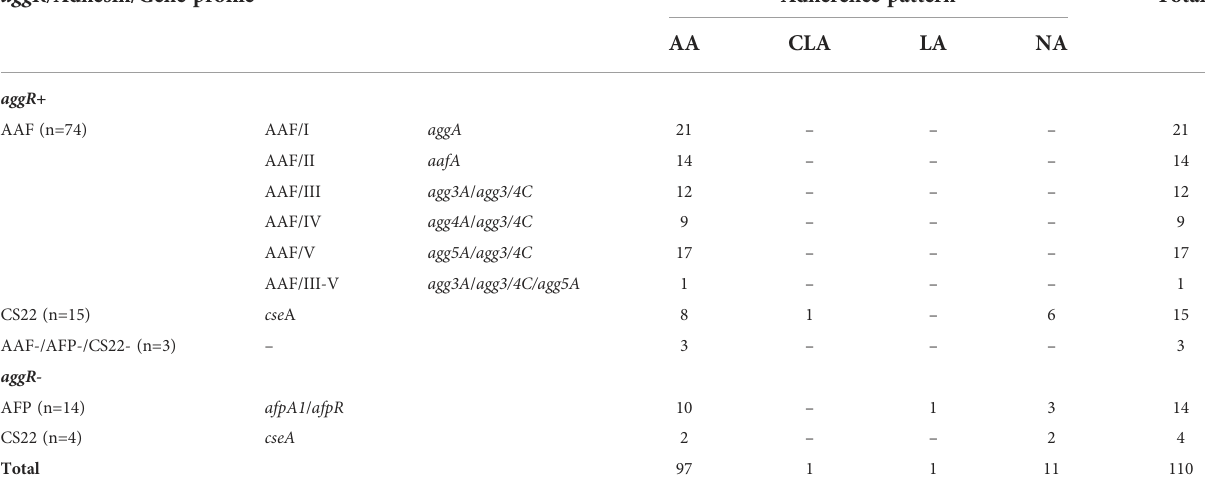
TABLE 2 Adhesin related genes and adherence pattern of 110 aatA + EAEC strains studied.